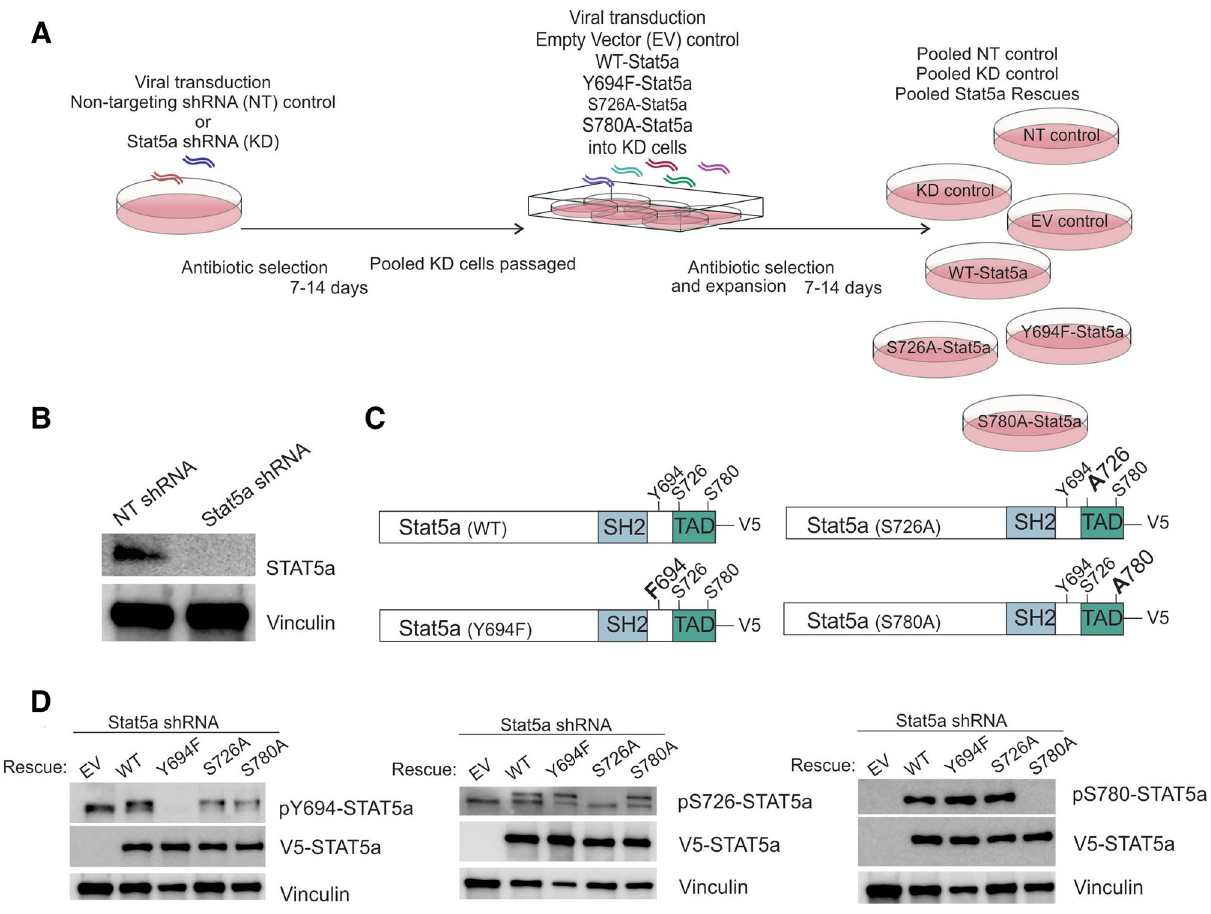
Figure 2. The human breast cancer cell line MCF7 as a model for STAT5a serine phosphorylation. ( A ) Schema for generating of stable knockdown and rescue cell lines generated in CorelDraw Graphics Suite X7 (Version 17.0.0.491, www. corel. com). ( B ) STAT5a knockdown in MCF7 cells after antibiotic selection confirmed by WB. ( C ) Representations of WT-, Y694F-, S726A-, and S780A-STAT5a constructs with C-terminal V5 tags used to generate MCF7 rescue cell lines. Confirmation of STAT5a rescue expression in MCF7 cells by ( D ) protein analysis with appropriate antibodies targeting each phospho-site of transcript expression was 250–400-fold higher than that of the nontargeting control (Supplemental Figure S2). However, on the protein level, STAT5a was equally expressed by the rescues (Fig. 2D). Therefore, quantifica- tion of all subsequent studies using these MCF7 pooled rescue cell lines is reported normalized to V5-STAT5a expression. These generated stable MCF7 cells were then stimulated with PRL (250 ng/mL) and subjected to RNA sequencing (RNA-seq), to assess global transcriptomic changes following STAT5a mutagenesis. These analyses revealed that following PRL treatment, MCF7-WT-STAT5a cells had 510 differentially expressed genes (DEGs), and each STAT5a phospho-deficient mutant had fewer DEGs than the WT-STAT5a [ranging from 171 (Y694F- STAT5a) to 285 DEGs (S726A-STAT5a); Supplemental Table S3]. Next, the top 50 DEGs from the four STAT5a rescues when treated with PRL vs untreated (for a total of ~ 200 DEGs) were subjected to supervised clustering (Fig. 3A). Results from Y694F-STAT5a MCF7 cells treated with PRL were most similar to untreated WT-STAT5a MCF7 cells, indicating that loss of Y694-STAT5a is sufficient to inhibit most PRL-induced transcript expression. Hierarchical clustering of all significant DEGs supported this finding (Supplemental Figure S3). When treated with PRL, S726A- and S780A-STAT5a MCF7 cells had similar expression of the top 50 DEGs from each con- trast, visualized by the clustering of the S726A + PRL and S780A + PRL samples. Interestingly, when untreated, the three STAT5a point mutants top 50 DEGs cluster away from the untreated WT-STAT5a MCF7 cells. This indicates that in these cells STAT5a may drive expression of a subset of genes in the absence of tyrosine or serine phosphorylation. This would be a distinct function for STAT5a that is independent from its role of inducible, phosphorylation-dependent gene expression, similar to descriptions of STAT3 17,37 . WT-STAT5a PRL-induced or inhibited genes were compared to previous PRL-transcriptomic data released by our laboratory, such that after matching the criteria that the DEG be present in at least two datasets, 105 putative PRL-regulated genes were identified (Supplemental Table S4) 38,39 . A subset of these genes were used to identify functionally-enriched pathways with PRL treatment that may be changed by expression of the STAT5a mutants through Ingenuity Pathway Analysis (IPA, Qiagen, Fig. 3B). The PRL treatment of WT-STAT5a MCF7